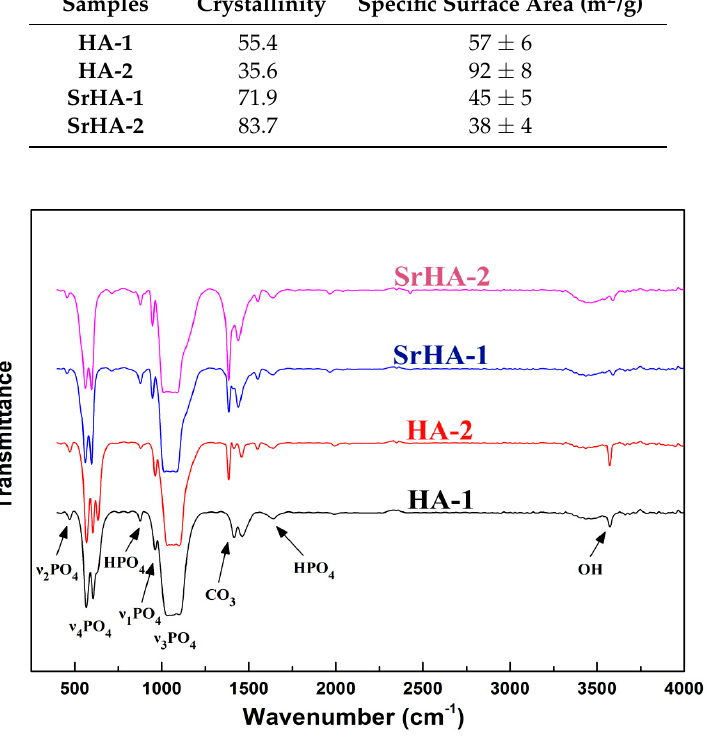
Figure 2. Fourier-transform infrared spectroscopy (FT-IR) spectra of the prepared powders. The main component of all samples is phosphate. SrHAs showed strengthened carbonate absorption intensity compared to HAs.